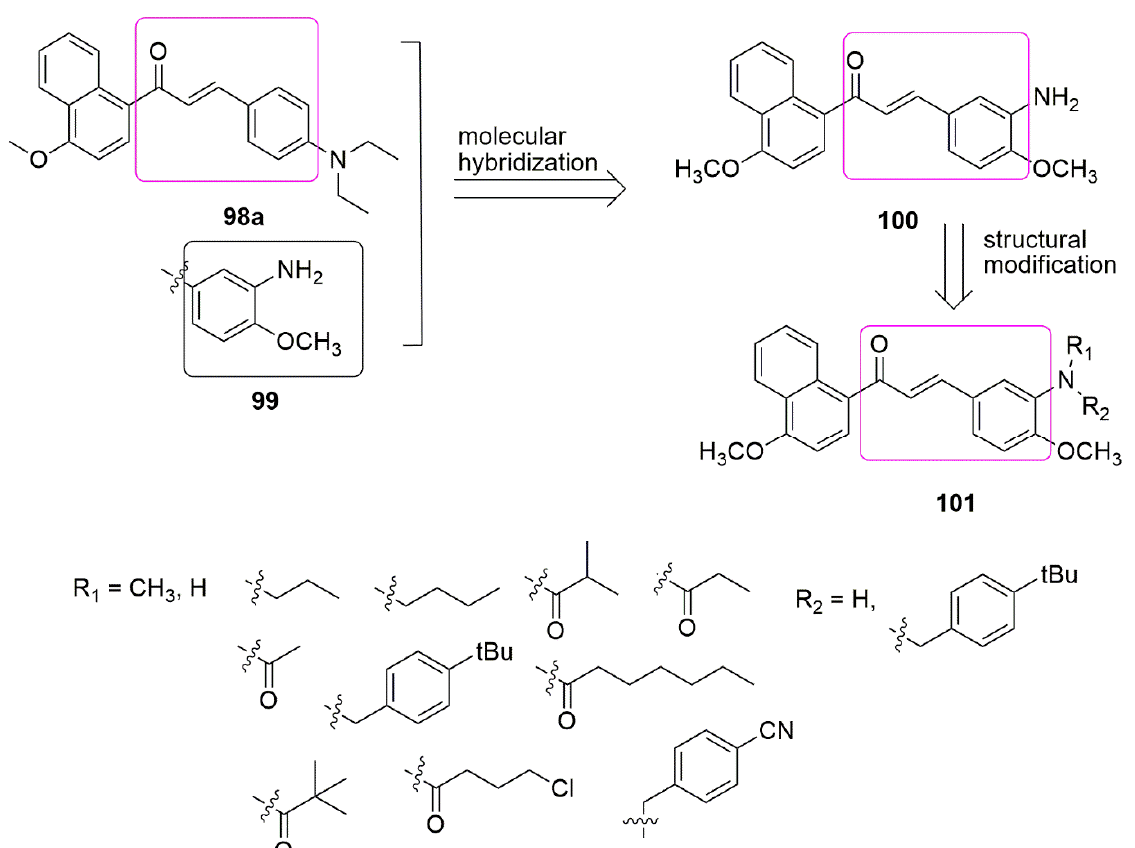
Figure 29. Chemical structures of chalcone hybrids evaluated against a panel of human cancer cell lines.